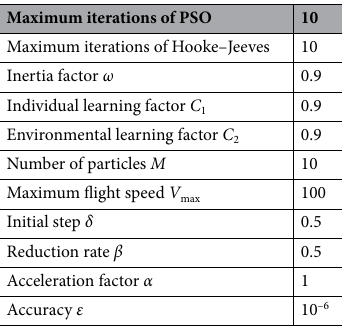
Table 7. HJ− PSO algorithm